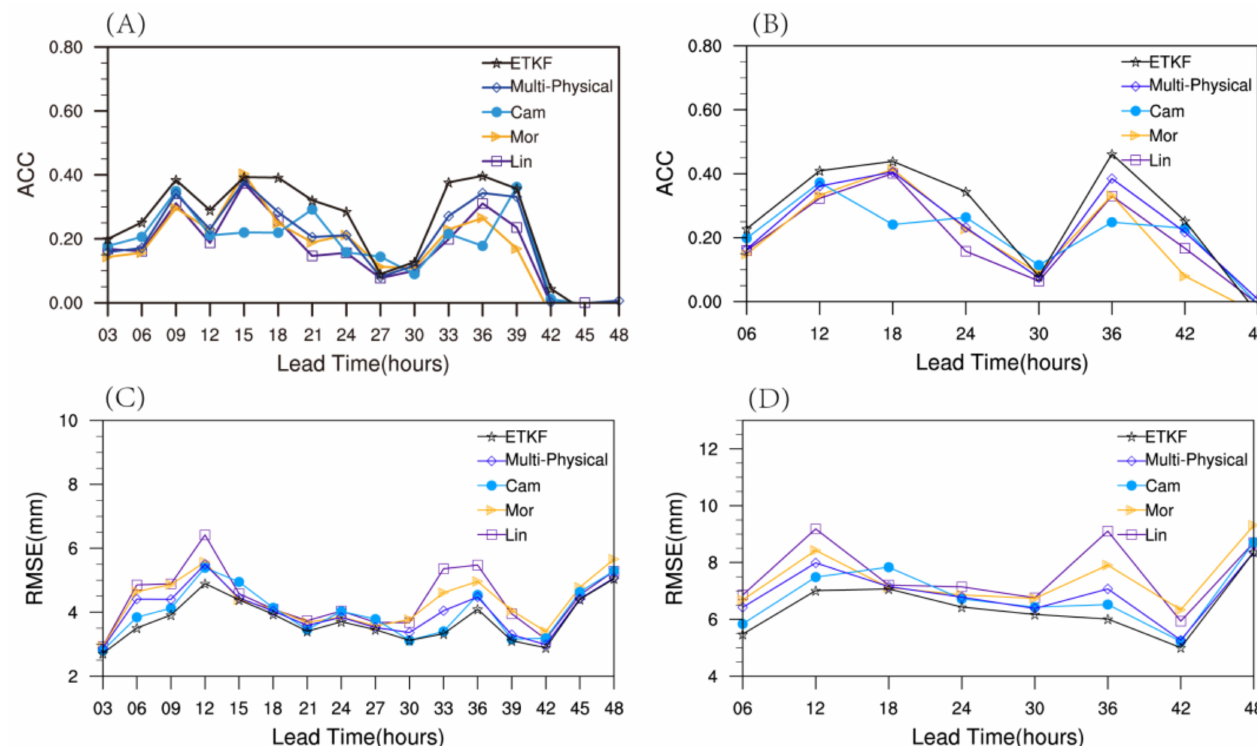
Figure 6. Taylor diagrams of the 3-hour ( A ) and 6-hour ( B ) accumulated precipitation simulated by the 15 perturbation members of ETKF at 0600 UTC on 12 August 2014. Purple represents results from Lin’s scheme, yellow indicates results from the Morrison 2-mom scheme, and blue denotes results from the CAM5.1 scheme.